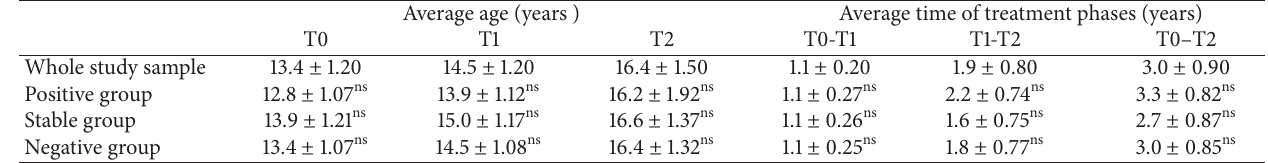
Table 1: Age at the beginning of phase 1 (T0), end of phase 1/beginning of phase 2 (T1) and end of treatment (T2), and duration of the treatment phases of the study sample ( 𝑁 = 30 ) and the three subgroups ( 𝑛 = 10 in each